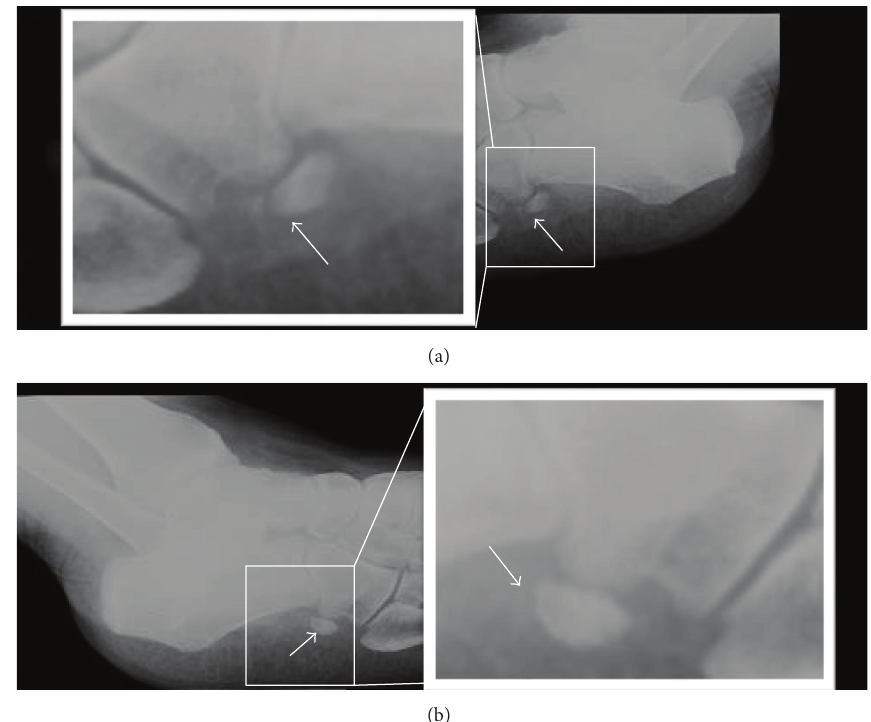
Figure 1: 60-year-old female plain film of the feet in an oblique view. (a) Right foot: complaint side, showing an irregular and fragmented os peroneum with heterogeneous density (arrow). (b) Left foot: comparative contralateral side, showing a regular and complete os peroneum with regular contours and homogeneous density (arrow).